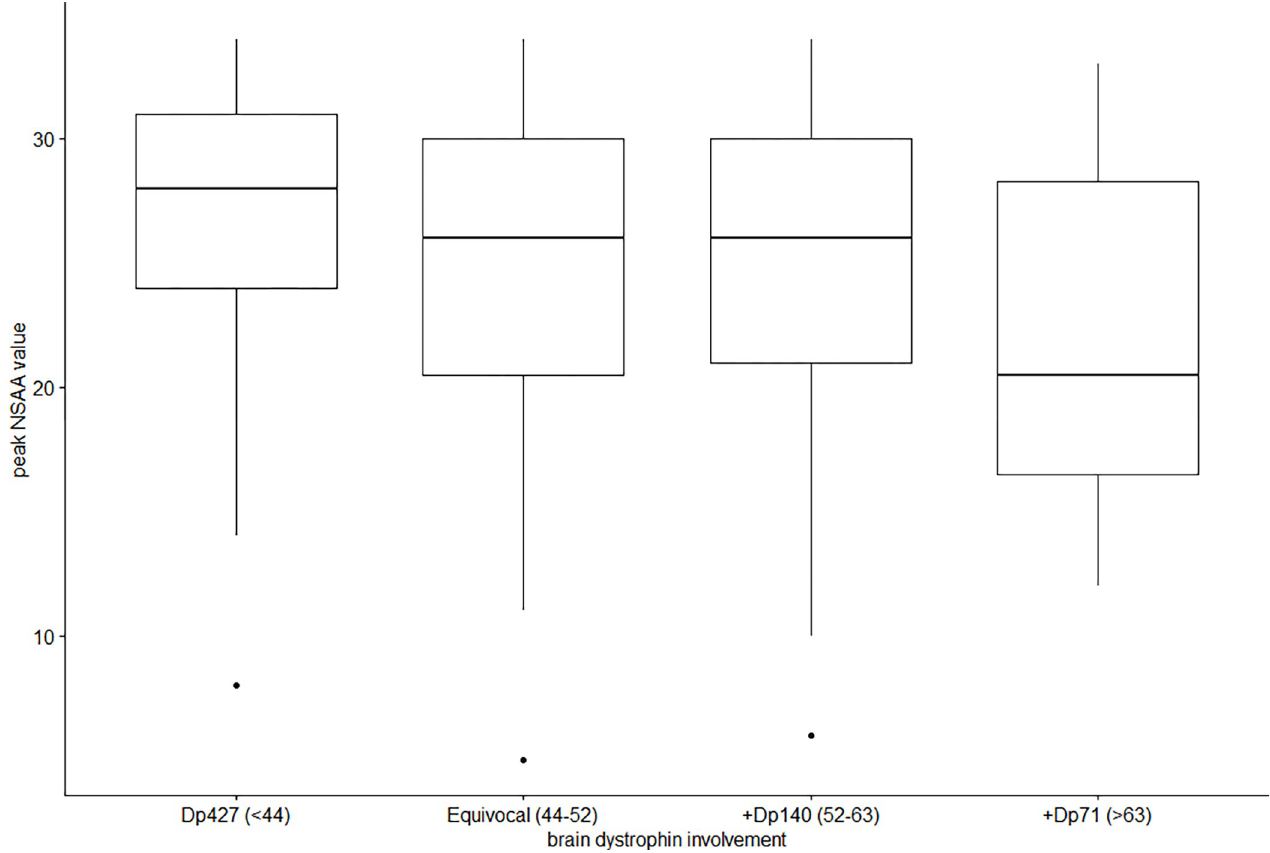
Fig 1. Maximum NSAA value and brain dystrophin involvement. Key to figure: Thick horizontal line = median value, box edges = 1 st and 3 rd quartile.